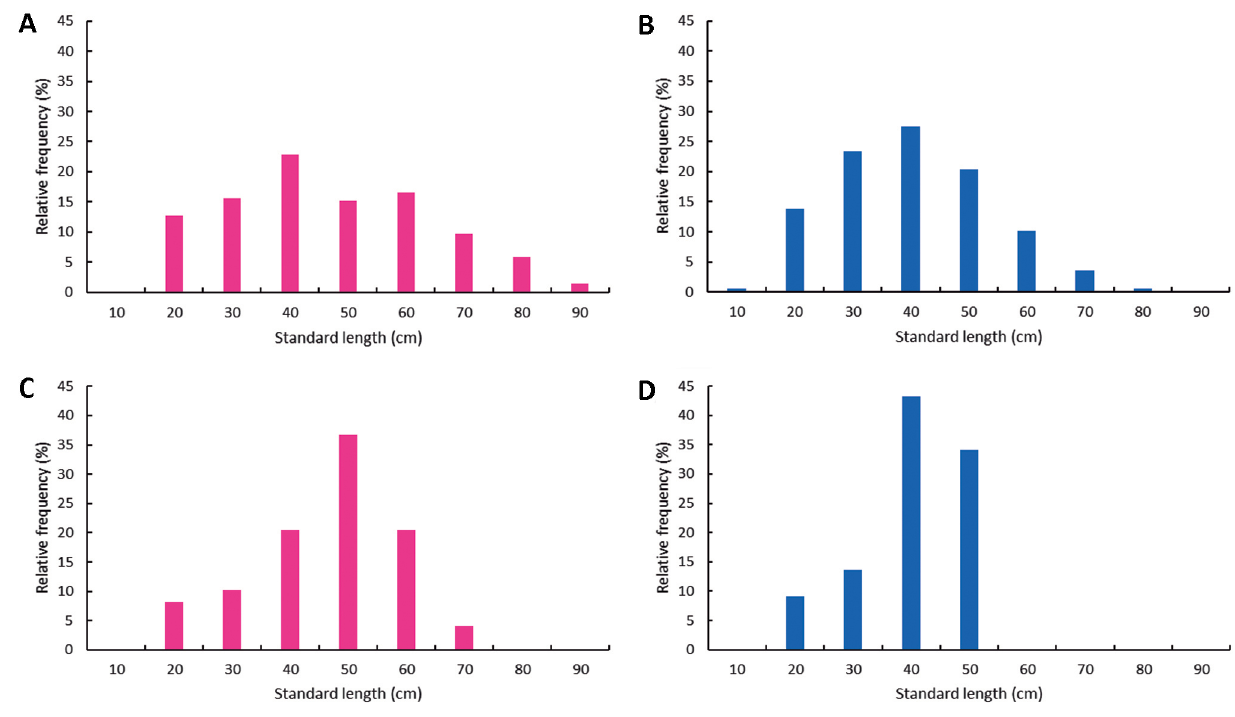
FIGURE 2 | Standard length frequency distributions of Pseudoplatystoma punctifer females (left) and males (right) in the A–B . AMU system and C–D . Putumayo River.